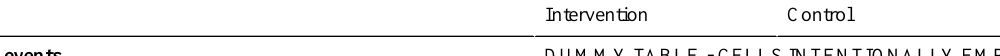
Table 3. Dummy table for number of adverse